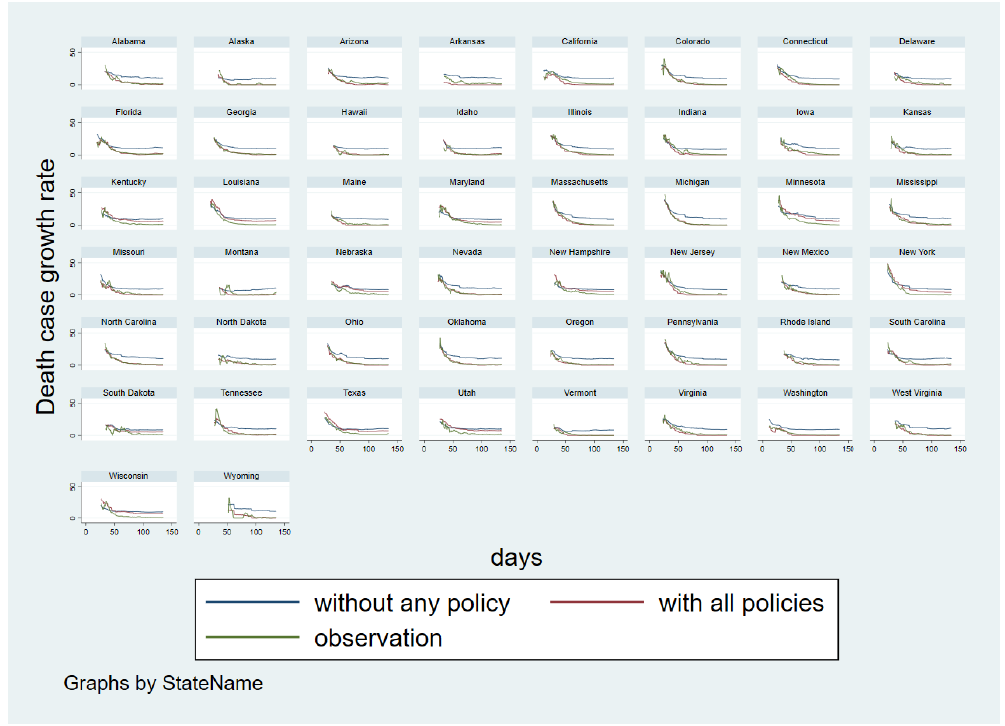
Figure A5. Counterfactual analysis: state-specific time trends for the death case growth rate with and without social distancing measures (7-day moving average).